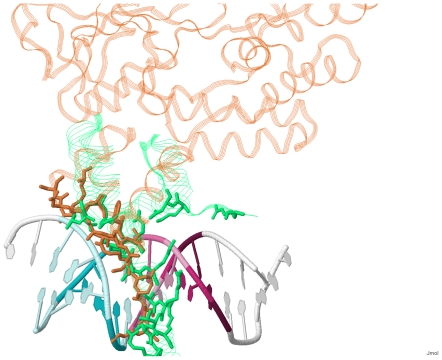
An example where the template has a low structure similarity to the query.This case demonstrates that using less similar templates still has the potential to produce satisfied results. This figure contains two proteins that share similar DNA-binding interface but have low global structure similarity (TM-score = 0.38). The Ψ-score of the predicted PWM to the annotated PWM using the orange protein (1MH3:A, MATA1_YEAST) as the query and the green protein (1SKN:P, SKN1_CAEEL) as the template is 0.18. Contact residues on both protein structures are plotted in sticks presentation.